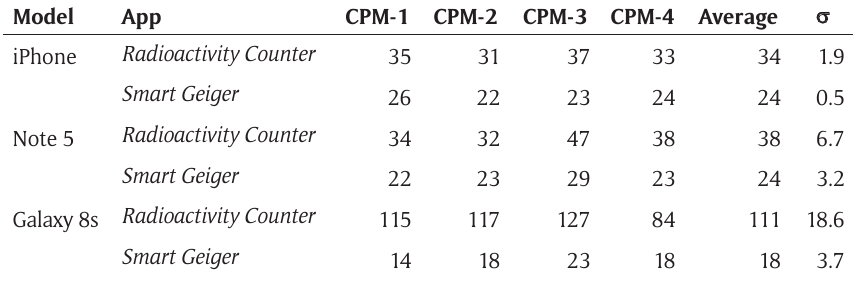
Table 6: Comparison of CPMs for apps on different platforms.